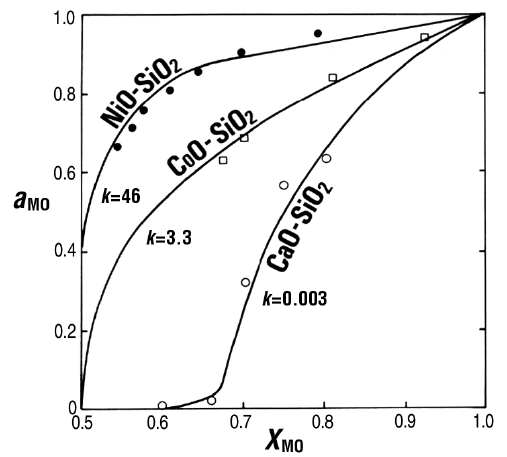
Fig. 1. Experimental measurements of oxide activ- ities in binary silicate melts. Also shown are curves calculated using a bi-functional linear polymer mod- el (see